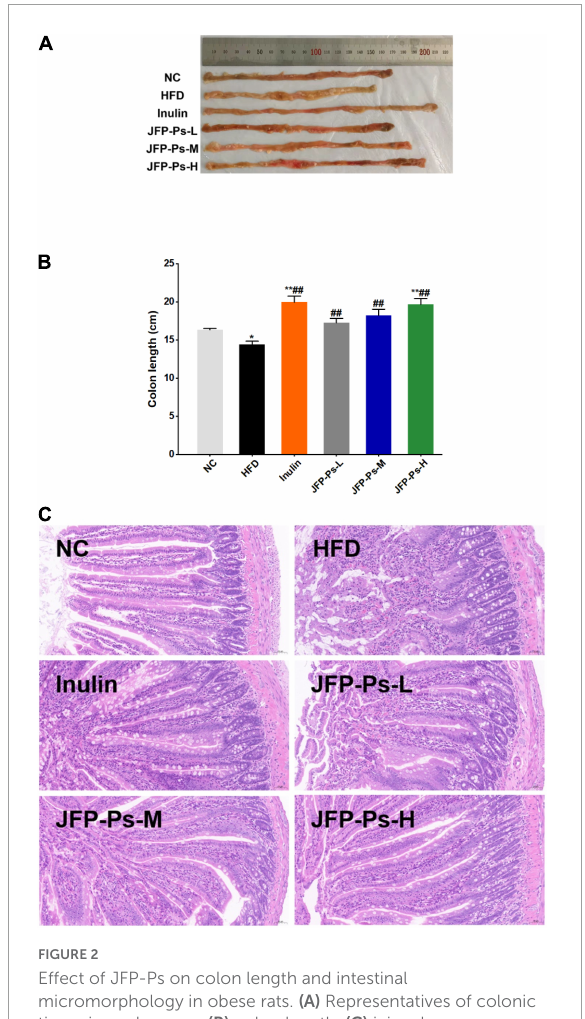
FIGURE2 Effect of JFP-Ps on colon length and intestinal micromorphology in obese rats. (A) Representatives of colonic tissue in each group, (B) colon length, (C) jejunal micromorphology (original magnification 20X). Data are expressed as mean ± SEM ( n = 6 for each group) and analyzed using one-way ANOVA. * p < 0.05, ** p < 0.01 compared to the NC group; ## p < 0.01 compared with the HFD